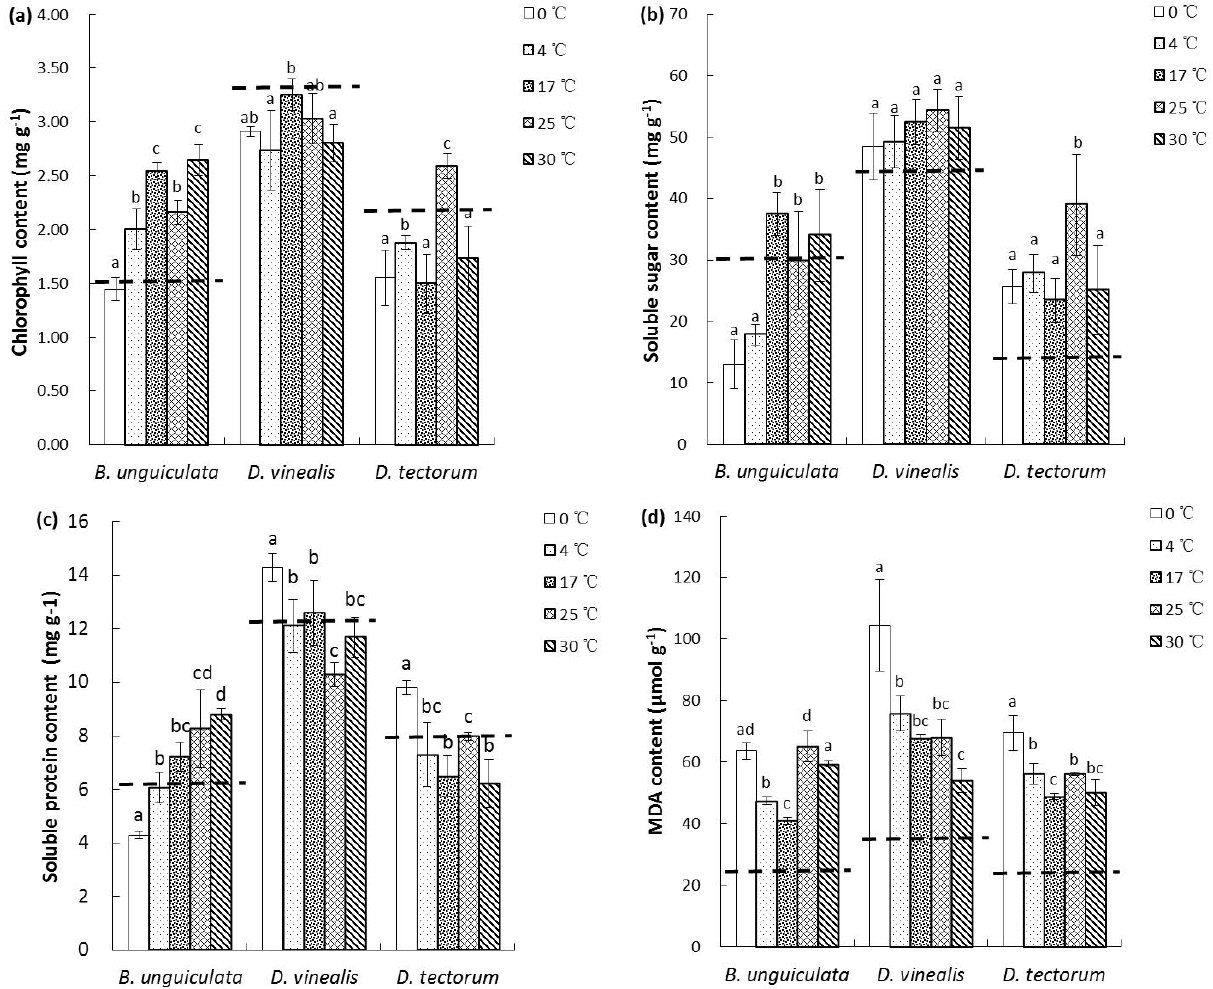
Figure 2. (a–d) Data (average ± 1 SE) for the three moss species on (a) chlorophyll content, (b) soluble sugar content, (c) soluble protein content, and (d) MDA content after the 40-day storage period at each of the five temperatures. Different letters indicate significant differences ( P < 0 . 05) among the five temperatures within the same species. Dotted lines represent the approximate values of the two germination parameters before storage for each species (the true values are shown in Table 1).